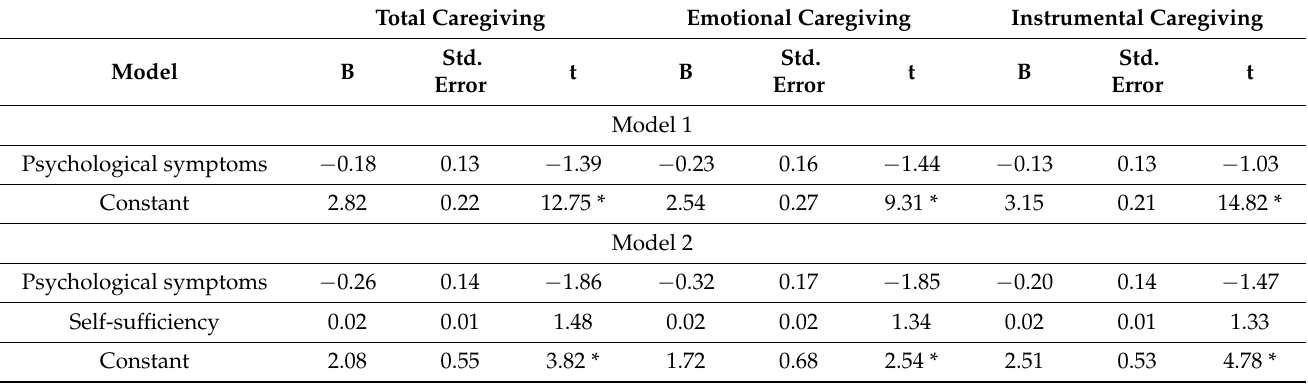
Table 2. Maternal caregiving capacity and relatively stable